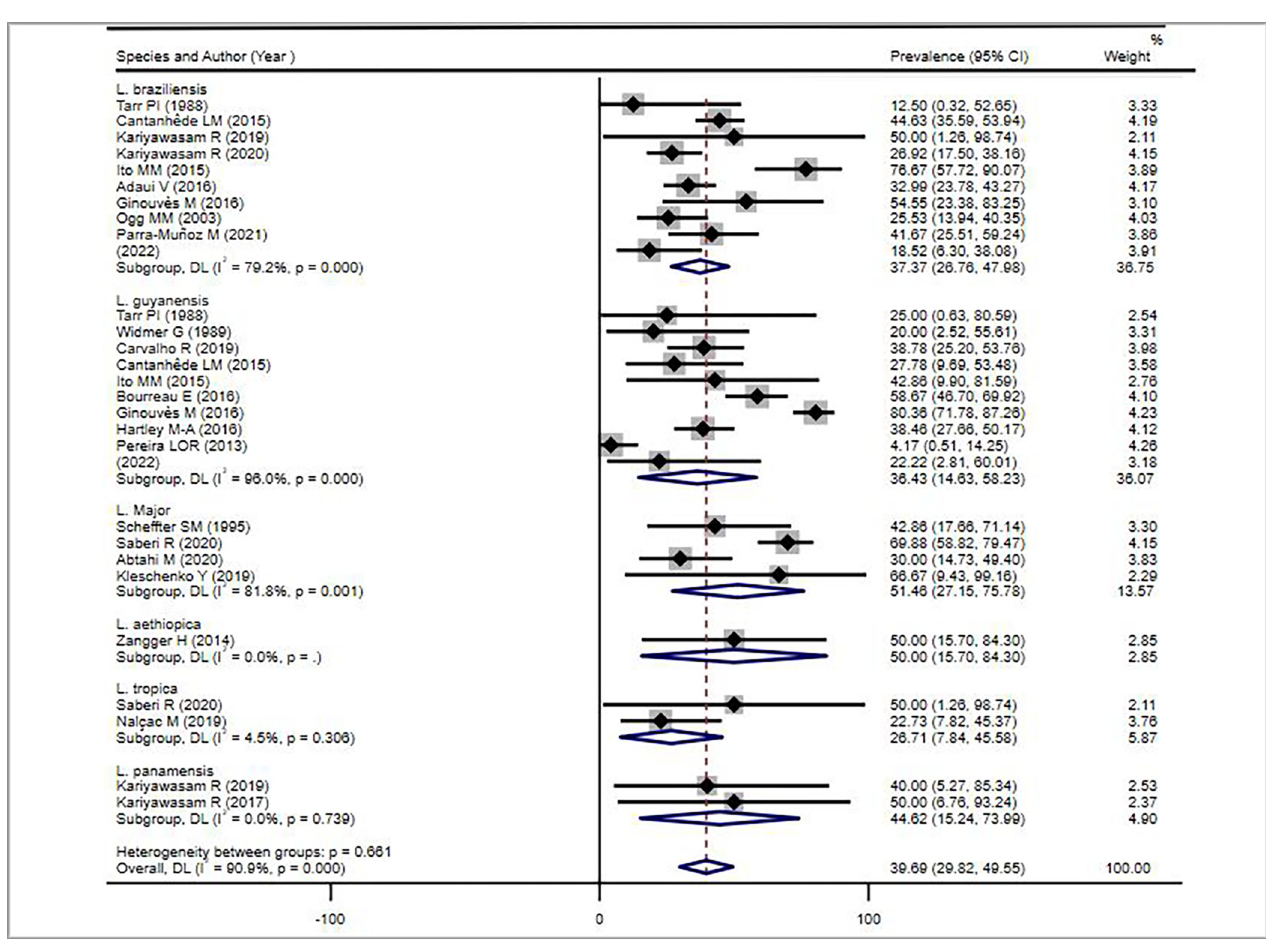
Fig 6. Forest plot showing the pooled LRV prevalence estimate in different Leishmania species from patients with cutaneous leishmaniasis, 2021.